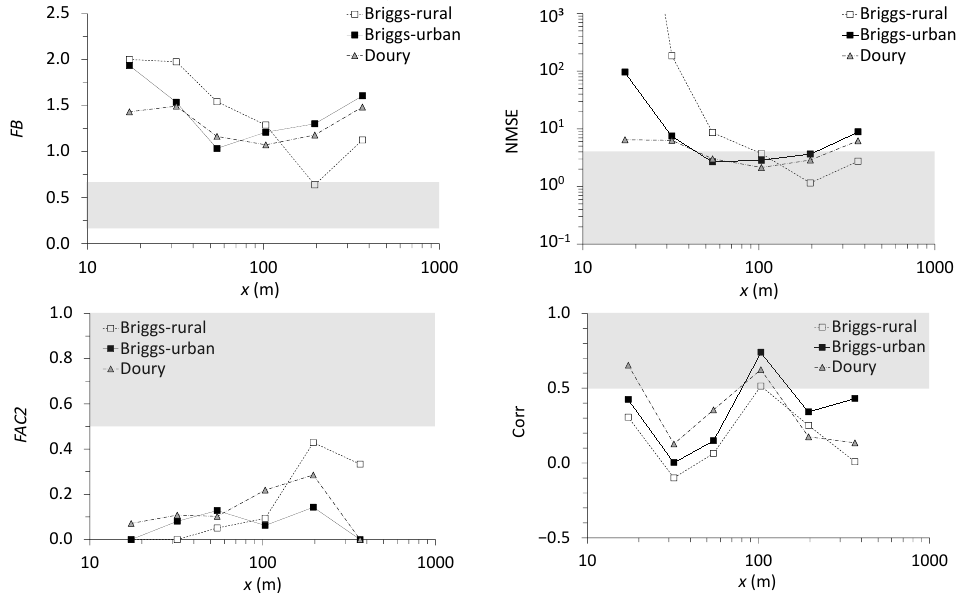
Figure 6. Evaluation criteria FB , NMSE , FAC 2 and Corr for Briggs-rural, Briggs-urban and Doury Gaussian models when predicting the atmospheric transfer coefficients measured CTA o as a function of distance x from the discharge point; the acceptability zone for each criterion is shown in grey.